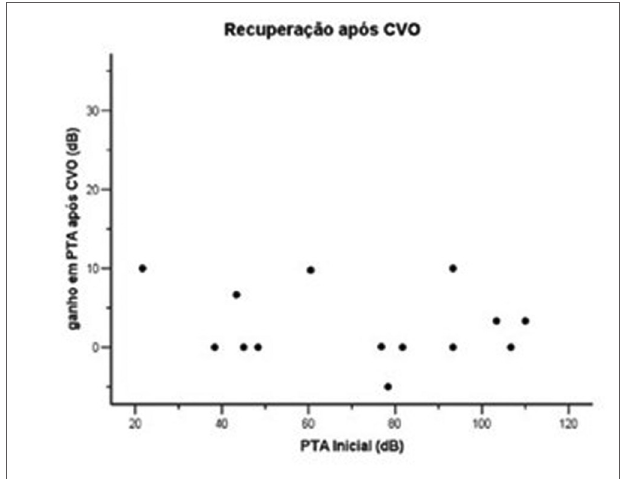
Figura 1. Recuperação após Corticoterapia Via Oral.